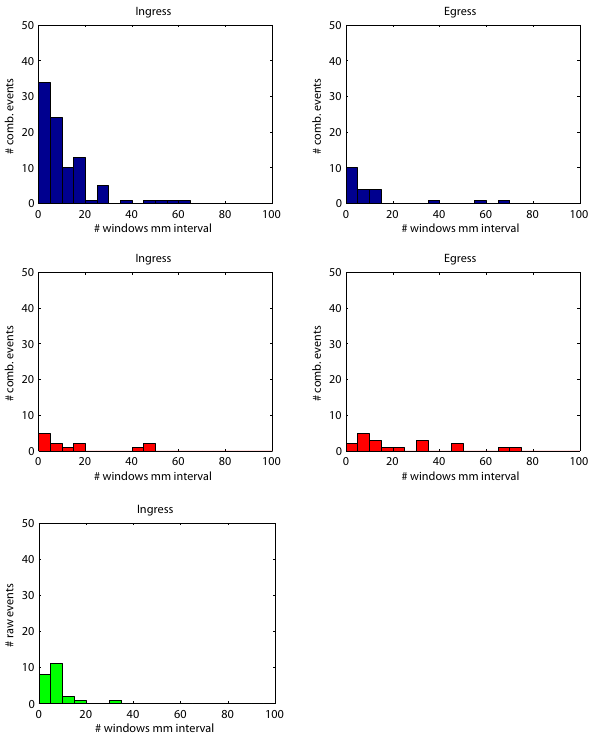
Figure 6. Histograms of the number of time windows in which Fig.6. HistogramsofthenumberoftimewindowsinwhichMMswereobservedpereventatingress(left)and egress (right) for Giotto (blue), VEGA 1 (red) and VEGA 2 (green). To obtain the length of the MM interval MMs were observed per event at ingress (left) and egress (right) the length of the window, 30 s, should be added to the size of the bin. For VEGA 2 the requirement on the for Giotto (blue), VEGA 1 (red) and VEGA 2 (green). To obtain the amplitude ∆ B/B > 0 . 3 hasbeendropped,andthusthenumberofeventsisincreased. length of the MM interval the length of the window, 30s, should be added to the size of the bin. For VEGA 2 the requirement on the amplitude (cid:49)B/B > 0 . 3 has been dropped, and thus the number of events is increased. 24 Fig.8. OverviewofallMMintervalsfortheVEGA1flyby,insimilarformatasFig.5. Figure 8. Overview of all MM intervals for the VEGA 1 flyby, in similar format as Fig.